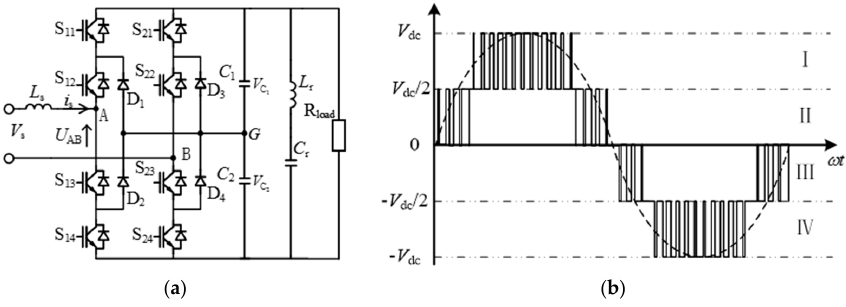
Figure 1. ( a ) Circuit configuration of 3L-NPC; ( b ) five-level waveform of terminal voltage.